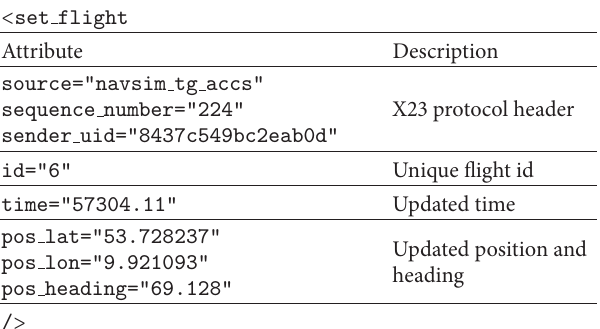
Table 3: The flight BER561K is updated with a new position.